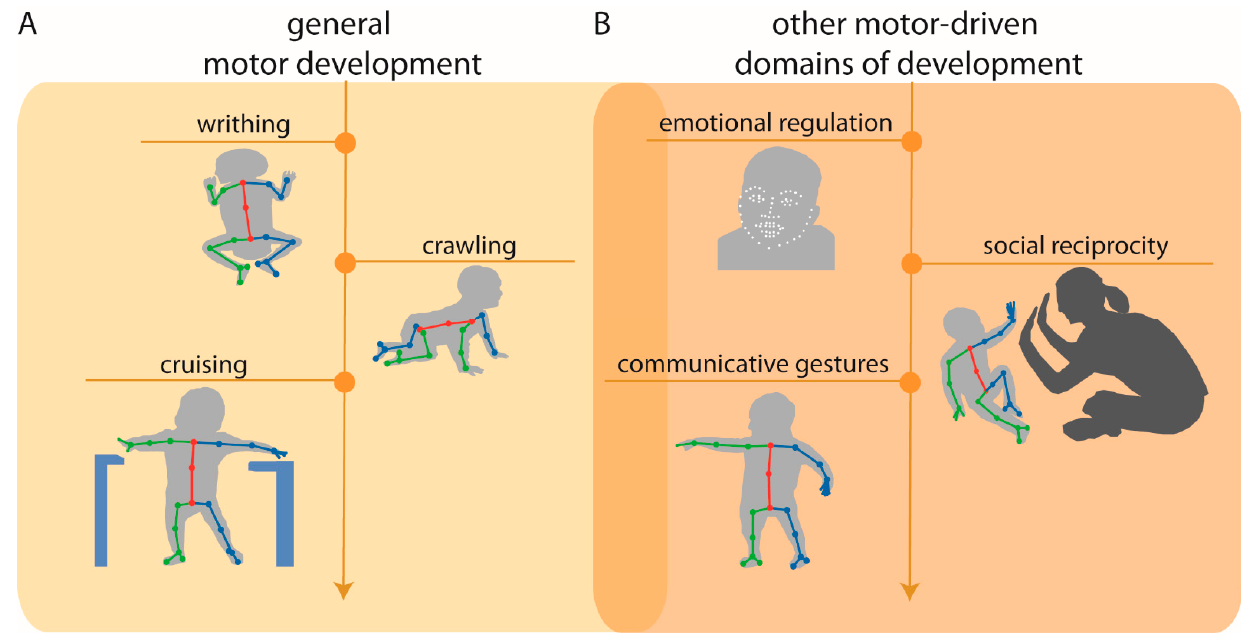
Figure 3. ( A ) Example applications of pose estimation to quantify early motor developmental milestones (left), including writhing movements (e.g., [51]), crawling, and cruising (e.g., [36]); and ( B ) other motor-driven domains of development, including emotional regulation, social reciprocity, and communicative gestures. Overlap between ( A , B ) denotes that these areas of development are intimately linked with one another. Arrow indicates that application of pose estimation is not restricted to these examples and can be applied to quantify later motor and motor-driven developmental milestones.